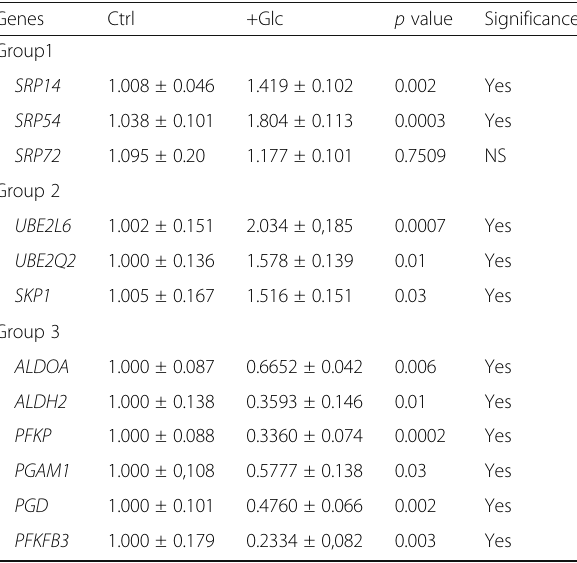
Table 5 Confirmation of mRNA expression of genes from molecular pathways Genes Significance